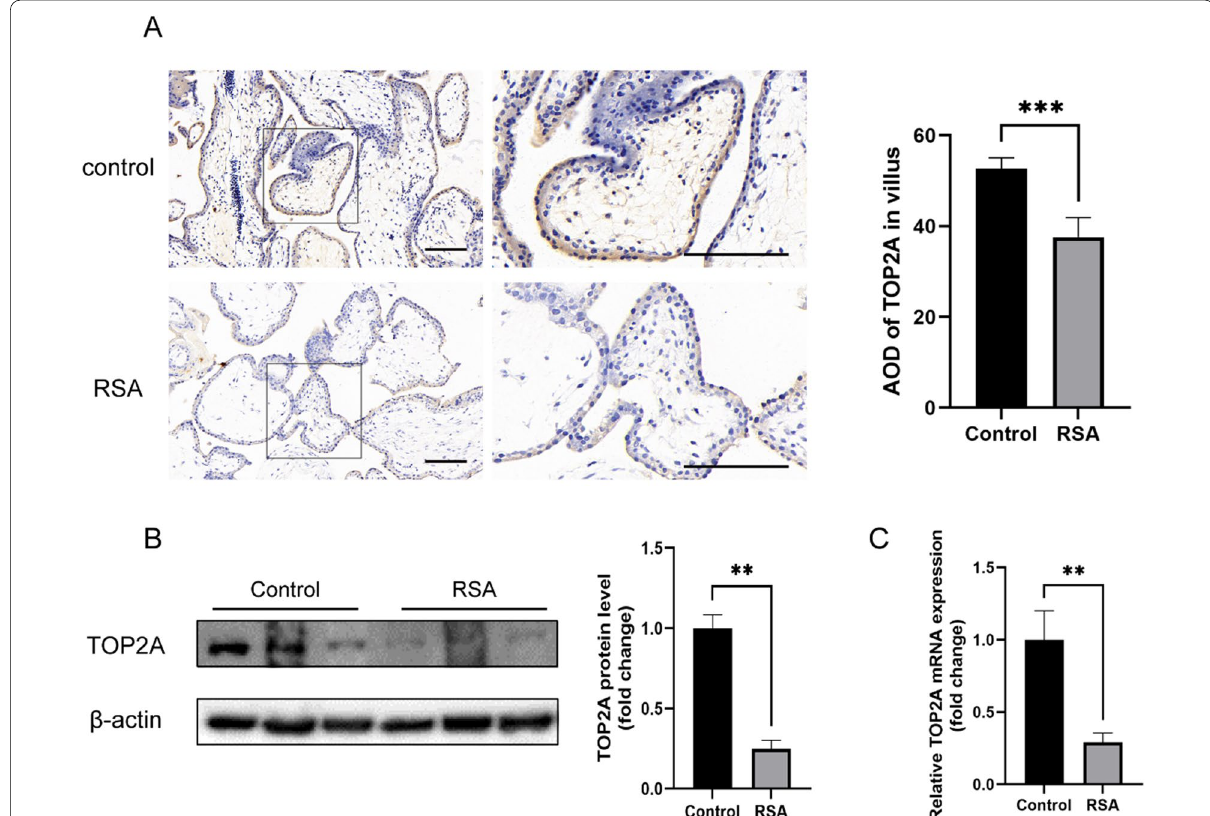
Fig. 1 DNA Topoisomerase II Alpha (TOP2A) is expressed in low levels in villus of patients with recurrent spontaneous abortion (RSA) and is associated with RSA. A Immunohistochemical staining of TOP2A ( n Western blotting to assess TOP2A expression at the protein level in patients with RSA ( n the control group was analysed using qRT-PCR ( n mean (SEM). ** P < 0.01, *** P < 0.001. Scale bar: 100 μm